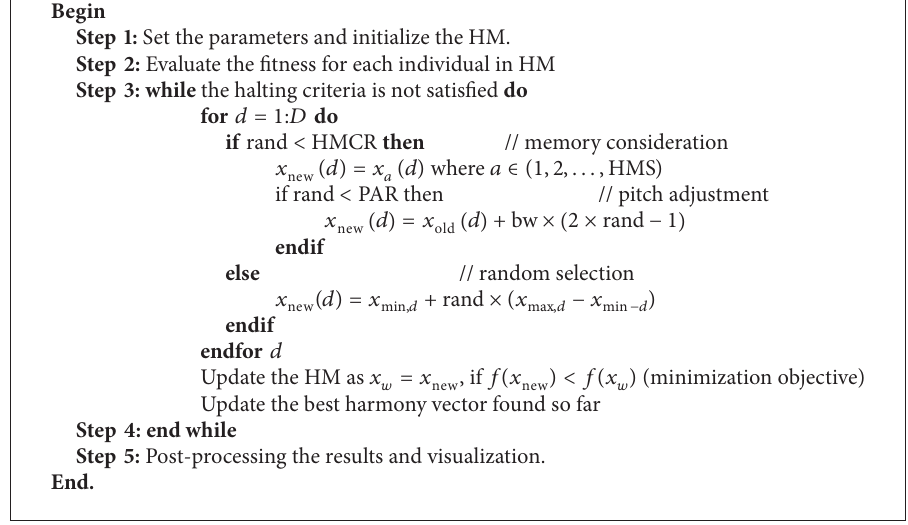
Algorithm 1: Harmony search